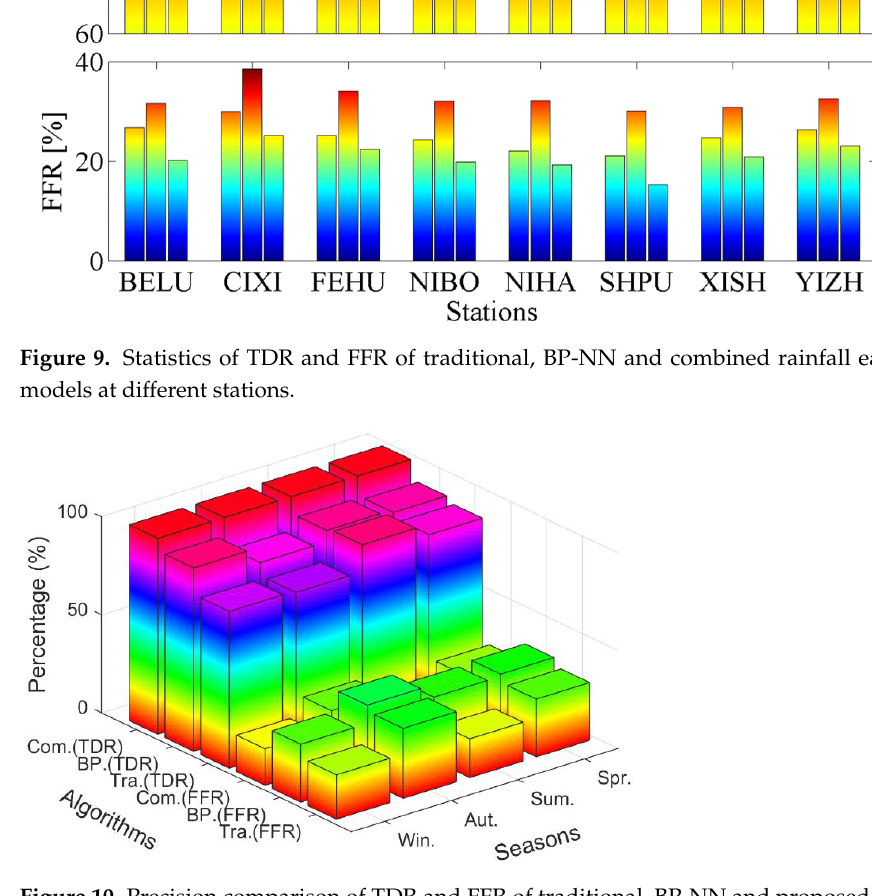
Figure 10. Precision comparison of TDR and FFR of traditional, BP-NN and proposed rainfall early warning models in four seasons. Table 4. Precision of TDR, FFR and MDR of traditional, BP-NN and combined rainfall early warning models (%).